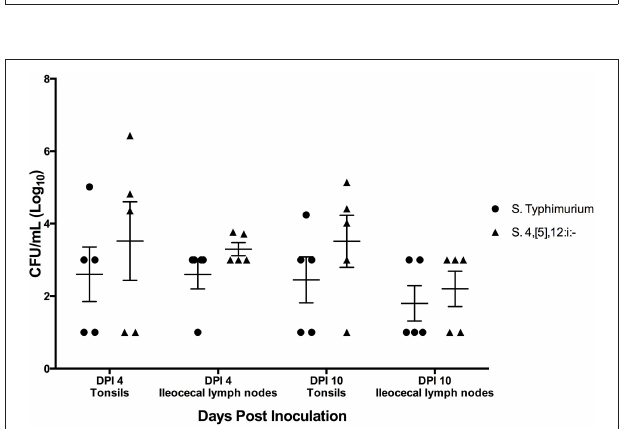
FIGURE 9 | Quantitative fecal culture results from animal study #3 in which pigs were co-inoculated with equal amounts of serovars of Salmonella : 4,[5],12:i:- and Typhimurium. Each data point represents the log 10 CFU/mL result in individual animals. The mean and standard error are represented by the horizontal and vertical lines, respectively. Asterisks represent days in which the mean amount of S. 4,[5],12:i:- was significantly different from the mean amount of S. Typhimurium ( p < 0.05).